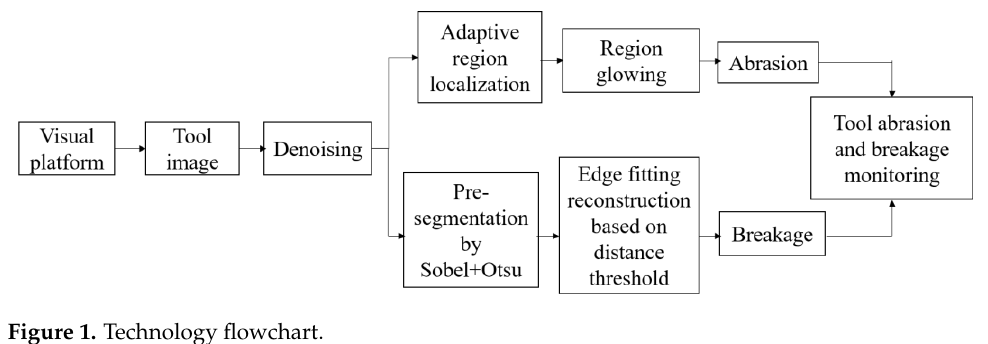
Figure 1. Technology flowchart.